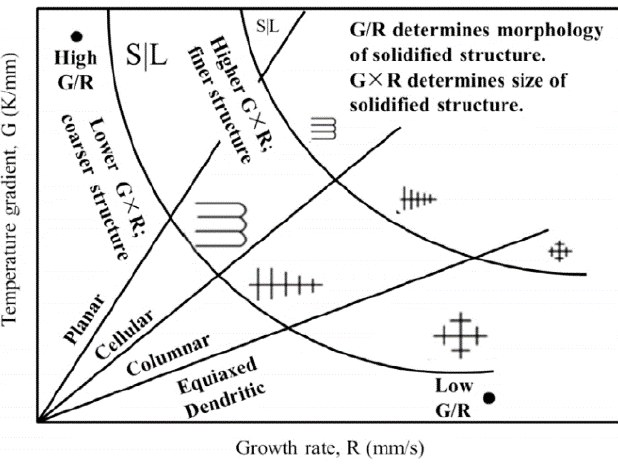
Figure 9. The effect of solidification parameters on the solidified microstructure, data from [25].